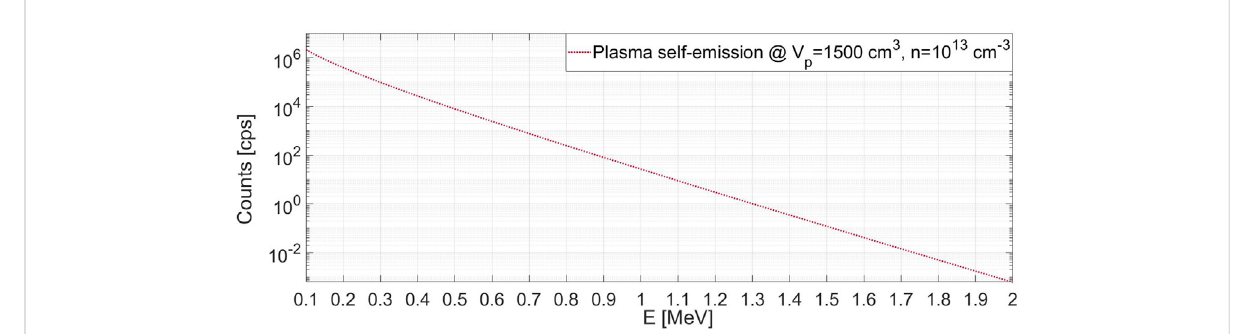
FIGURE 2 Example of the rate of plasma self-emission in the whole volume as a function of the energy of the radiation (the width of the bin in the x axis corresponds to 10 eV ).